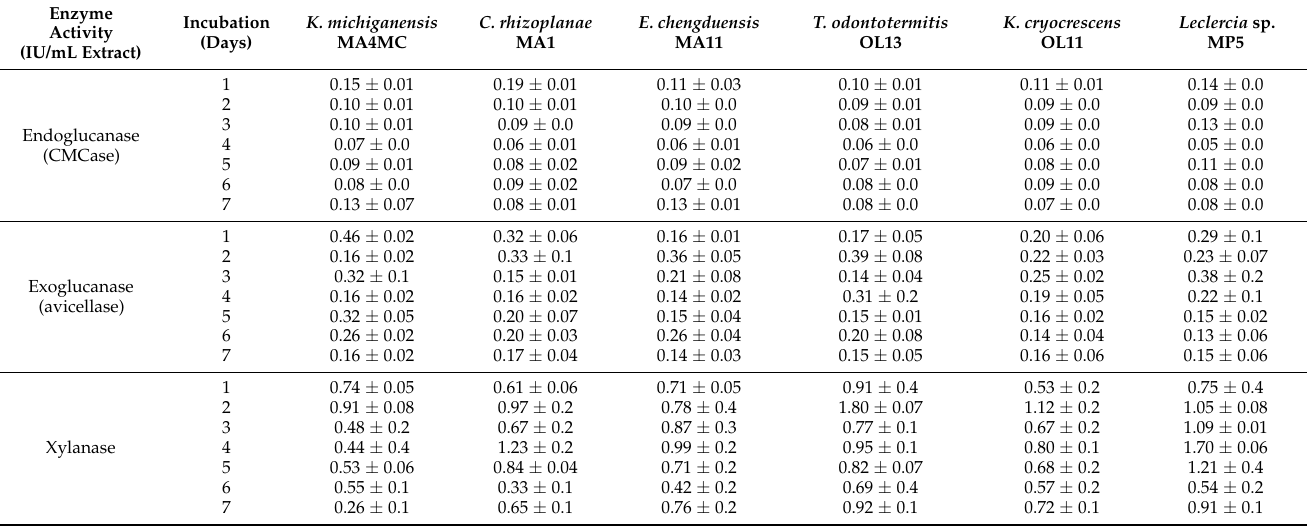
Table 4. Profile of the enzyme activities of the potential isolates during the growth on corn